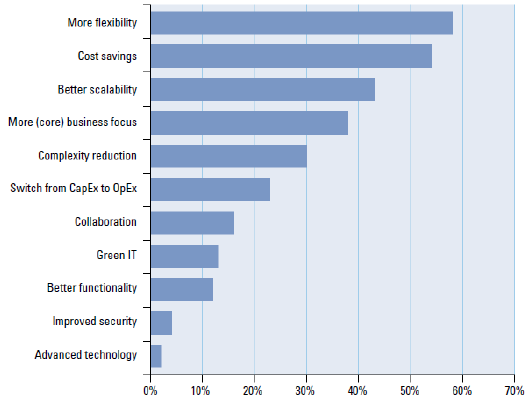
Figure 1. Benefits of Cloud computing.